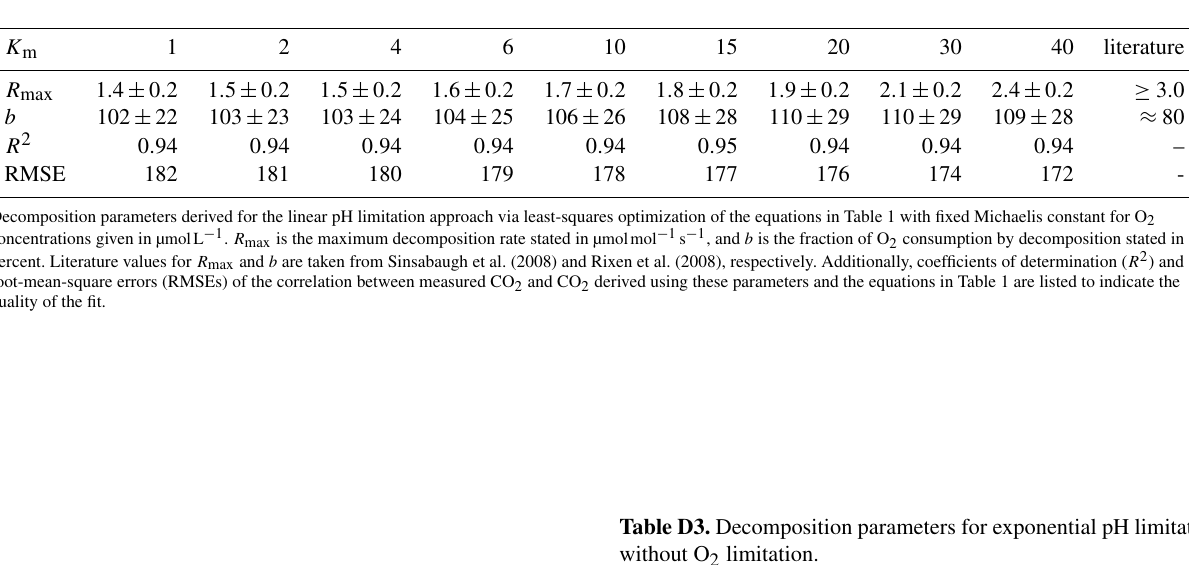
Figure D3. Correlation between measured and calculated concentrations of (a) CO 2 and (b) O 2 . Grey lines indicate the 1 : 1 line. Calculations were performed based on the equations in Table 2, which represent exponential pH limitation of decomposition rates. Each data point represents one river. Grey data points are excluded from the correlation since the data for these rivers are based on fewer than three campaigns within the same season. The Simunjan campaigns with high carbon concentrations are excluded from these figures and further discussed in the Appendix D5. The Simunjan campaigns with high carbon concentrations (Simunjan 2 , Table 4) are indicated by red circles. Table D1. Decomposition parameters for fixed K m values.